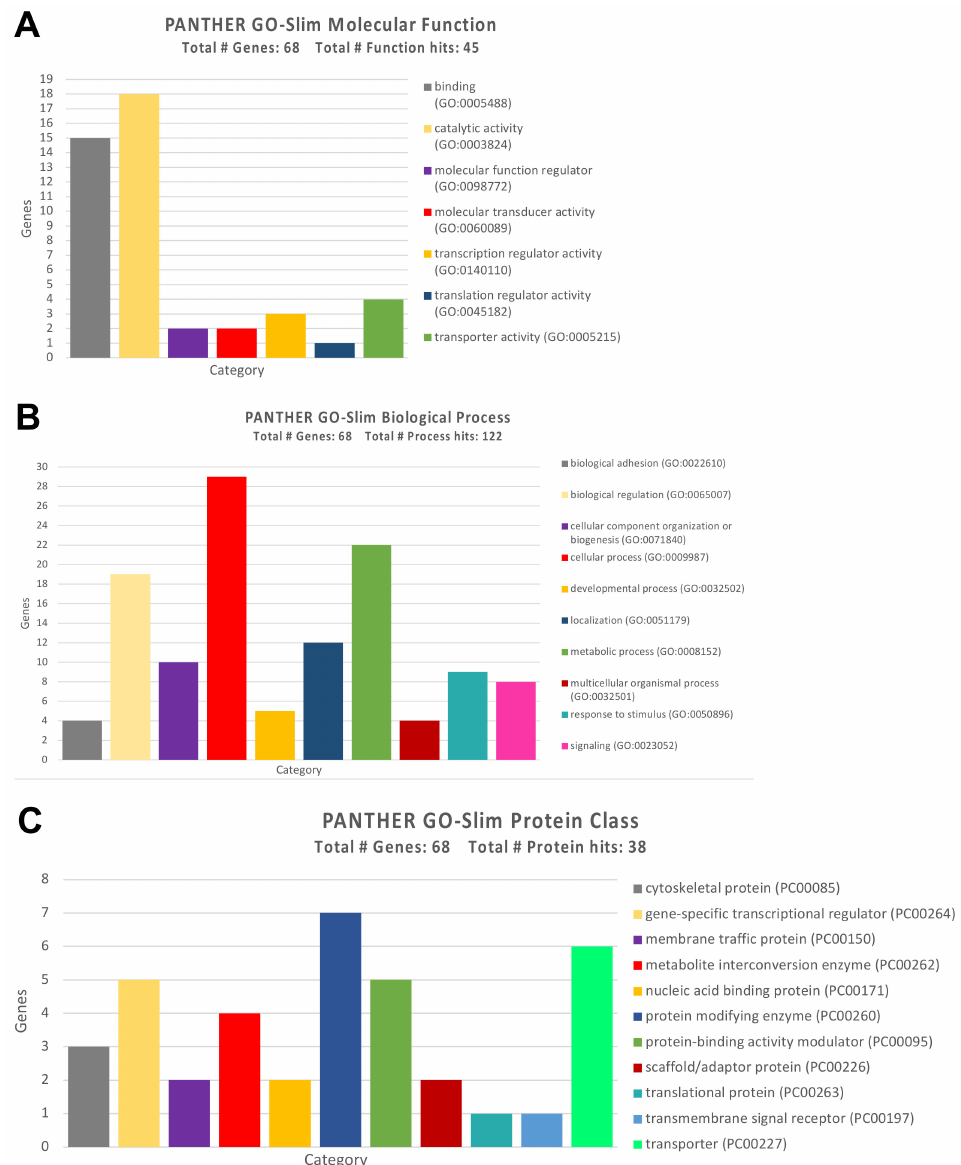
Figure 10. ( A ) GO Panther analysis of the molecular functions performed by genes differentially expressed after pesticide exposure; ( B ) GO Panther analysis of the biological processes in which the differentially expressed genes are involved; ( C ) GO Panther analysis of the protein classes of the differentially expressed genes after pesticide